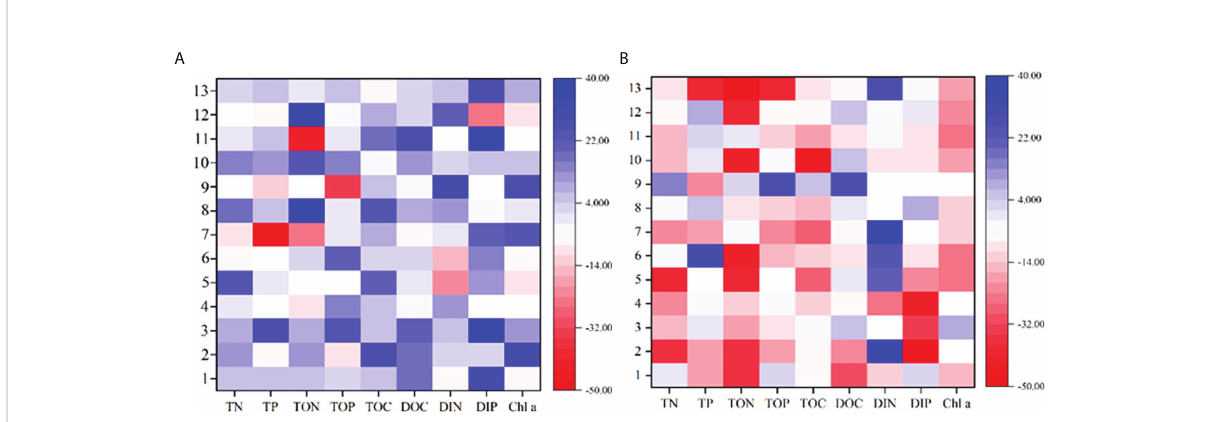
FIGURE 7 Changes in nutrients and Chl a in (A) the MC-regulated pond before and after spraying of MC and the comparison with (B) the control